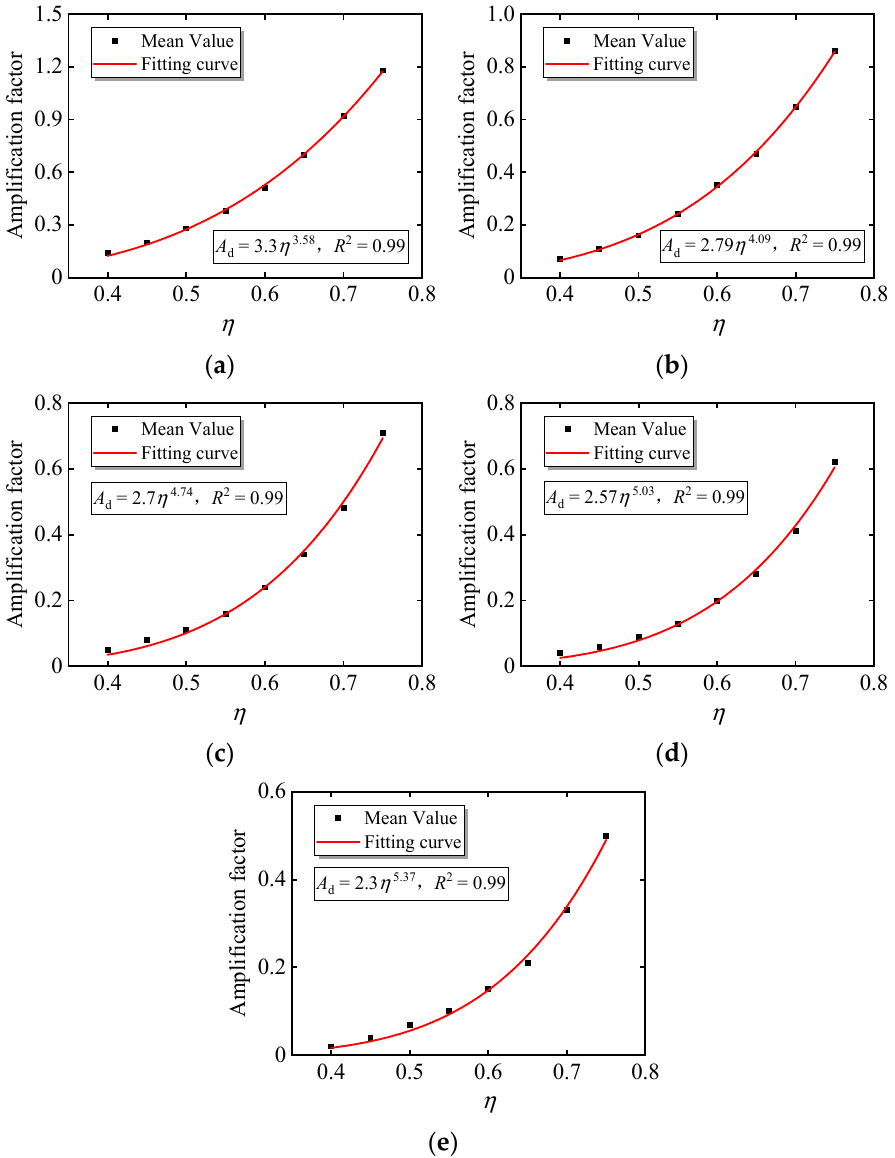
Figure 7. Curve fitting of mean value based on nonlinear amplification coefficient: ( a ) data fitting (20 MPa); ( b ) data fitting (30 MPa); ( c ) data fitting (40 MPa); ( d ) data fitting (50 MPa); ( e ) data fitting (60 MPa). Table 3. Power function coefficient value.